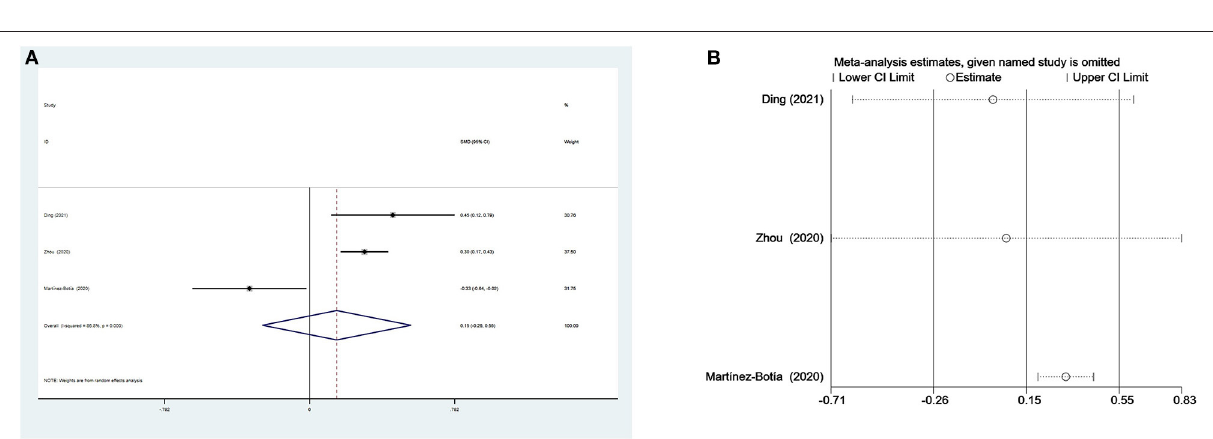
Frontiers in Psychiatry |